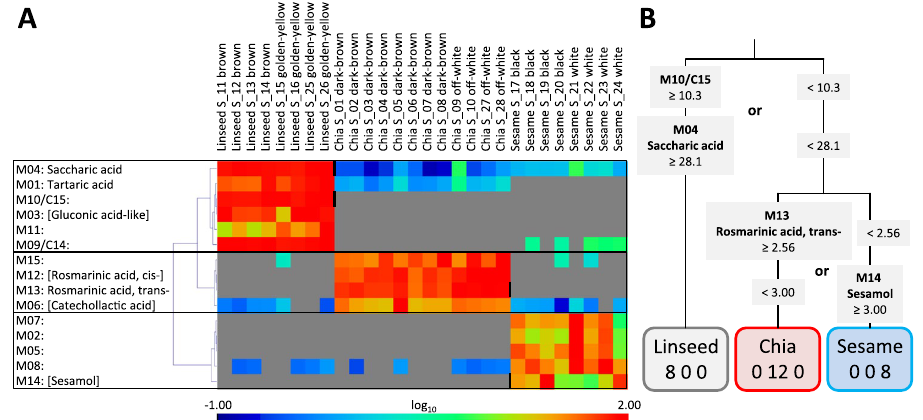
Figure 5. Min/Max - based selection of seed identity markers among mass features of non-targeted metabolite profiles of three chemical fractions from chia, linseed and sesame seeds. ( A ) Heat map representation of the normalized abundances of 15 Metabolites, M01-M15, that are markers of seed identity and grouped by seed type. The compounds were selected according to top 15 Min/Max ratios of mass features. Compound annotations by mass spectral match alone are reported in square brackets. Compounds without clear match were given an M identifier, e.g. M10 (also found as C15 in the subsequent analyses), and documented by mass spectrum and retention index (Supplemental Data File S5). The normalized abundances were maximum scaled and log 10 -transformed after mean centring for heat map visualization, maximum (red), mean (green), minimum (dark blue), and non-detected (gray). Note that this approach yields only “positive” markers of seed identity. Vertical black bars within the heat map indicate the sample partitioning rules of panel ( B ). Hierarchical clustering was by r² distance metric (Pearson’s correlation) and complete linkage. ( B ) Decision tree representation of two rule sets that distinguish three classes of seed material without misclassification. The rules were based on four metabolites, M04 (saccharic acid), M10/C15 (non-identified), M13 ( trans -rosmarinic acid), and M14 (sesamol). The numerical values are the partitioning